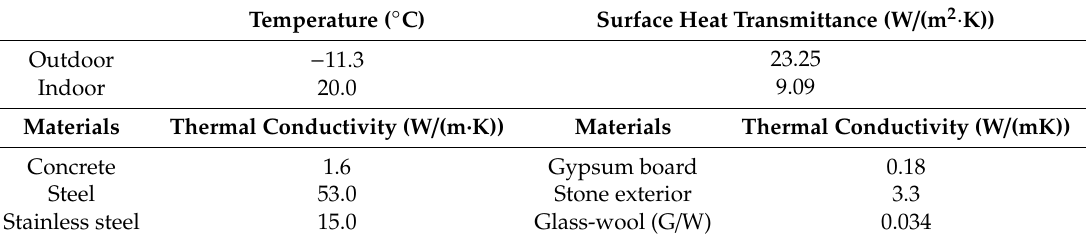
Table 6. Boundary conditions and material